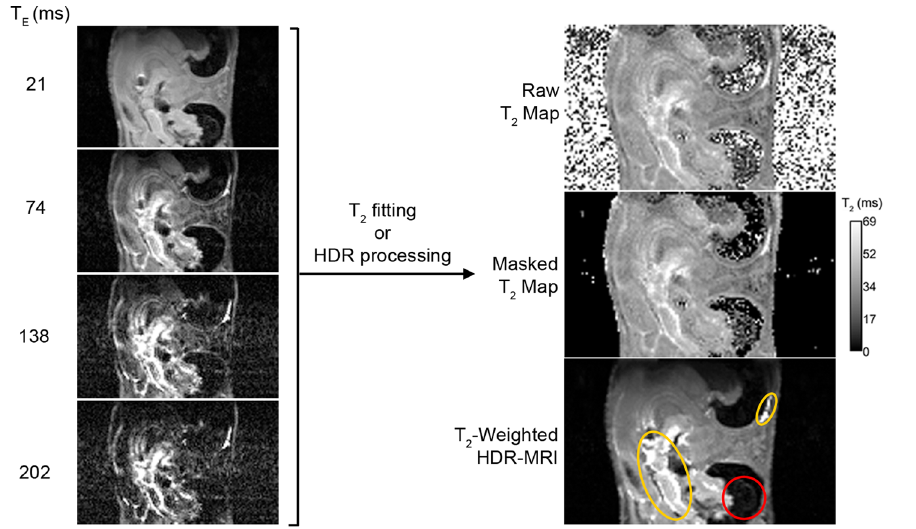
Figure 7. Invivo HDR-MRI. A series of images were acquired with constant T R at 5632 ms and varying T E as indicated. The same four LDR images were used to generate both the T 2 map and the HDR-MR image. Masking of the T 2 map was done by manual thresholding. In the HDR image, red and yellow outlines highlight features that were not captured in one or more of the individual LDR images. HDR-MRI captures the same features as T 2 mapping, but is less noisy in the low signal regions. Low signal features can be accurately depicted in HDR-MRI even when the features are only visible in a single LDR image.